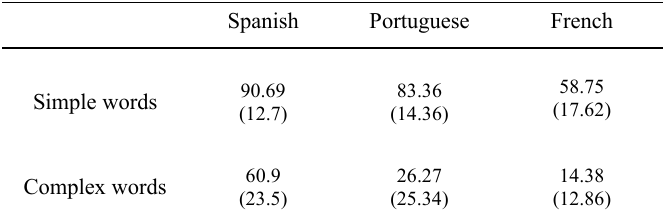
Table IV. Mean percentage of correct responses for simple and complex word spelling in Spanish, Portuguese and French at TP2 (February-March). Standard deviations in